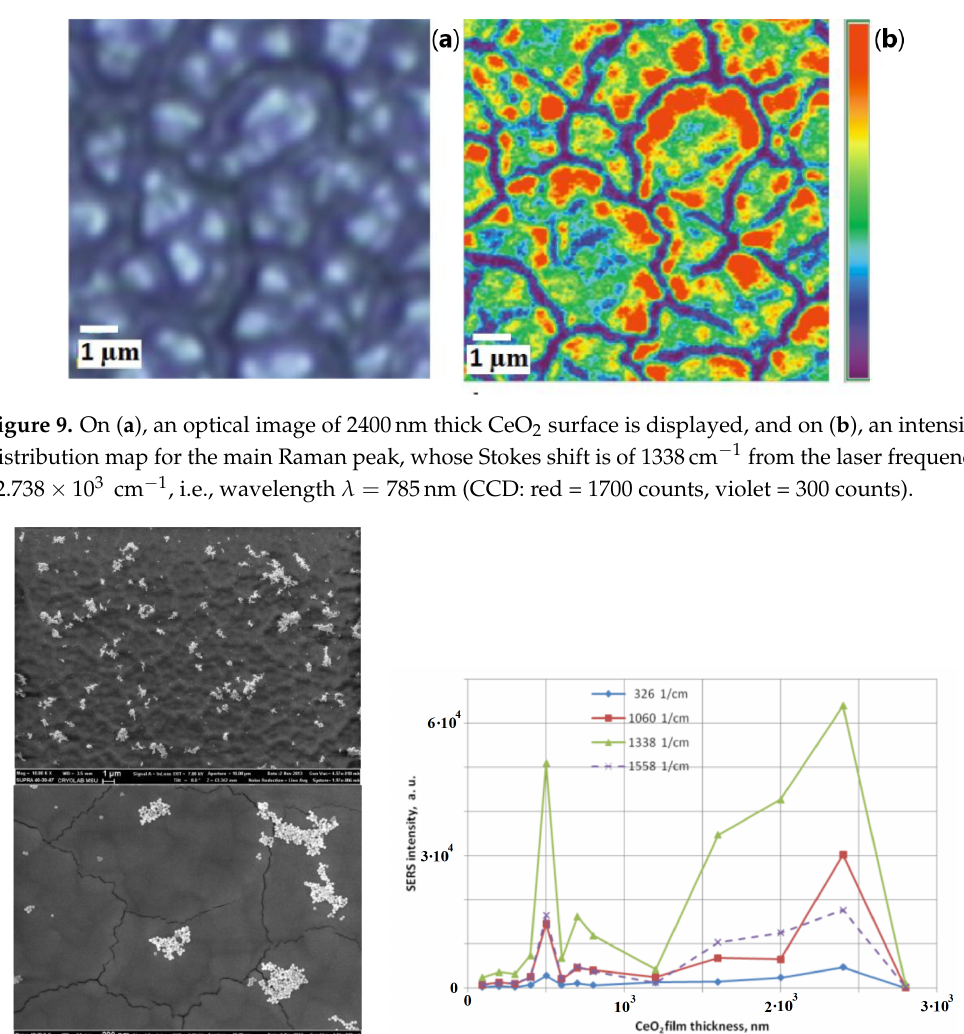
Figure 8. General ( a ) and cross-section ( b ) SEM views of CeO 2 film that have facet structure; the facet structure is clearly seen: the facets are separated by cracks whose thickness is about (cid:39) 50nm .